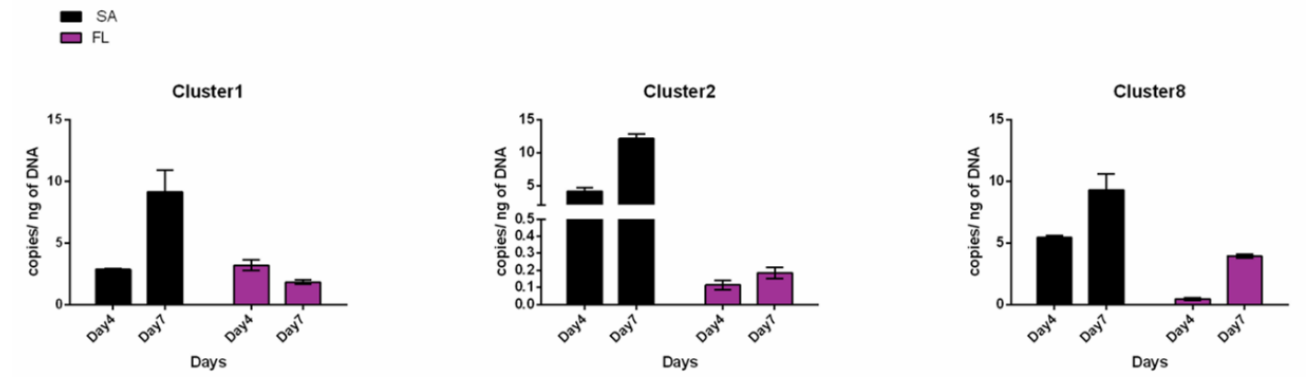
Figure 7. MAG distribution between the SA and FL diatom associated fractions. qPCR using Cl-1, Cl-2 and Cl-8 specific primers performed on SA and FL bacterial fractions collected from S. marinoi FE7 sampled on the 4th and 7th days of